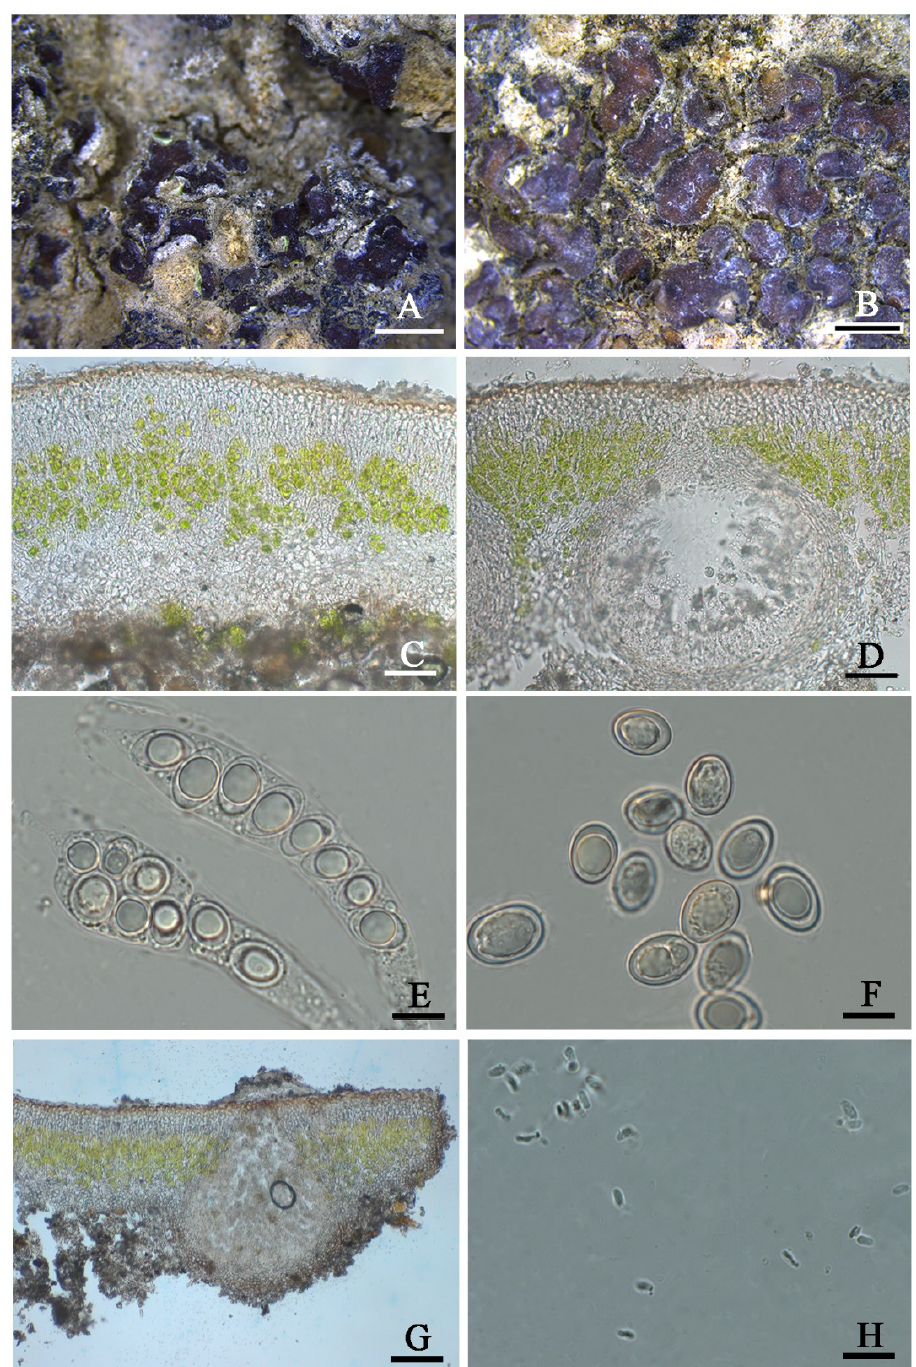
Figure 7. The thallus habit and the anatomic structure of Placicium varium sp. nov (holotype, HMAS–L 151970). ( A ). Squamulose thallus (HMAS–L 153948). ( B ). Squamulose thallus (HMAS–L 151967). ( C ). Thallus section. ( D ). Immersed perithecium. ( E ). Asci with biseriate and uniseriate ascospores. ( F ). Ascospores. ( G ). Pycnidium. ( H ). Conidia. Bars: ( A , B ) =2 mm, ( C , D ) =50 µm, ( E , F ) =10 µm, ( G ) =100 µm, and ( H ) =10 µm.